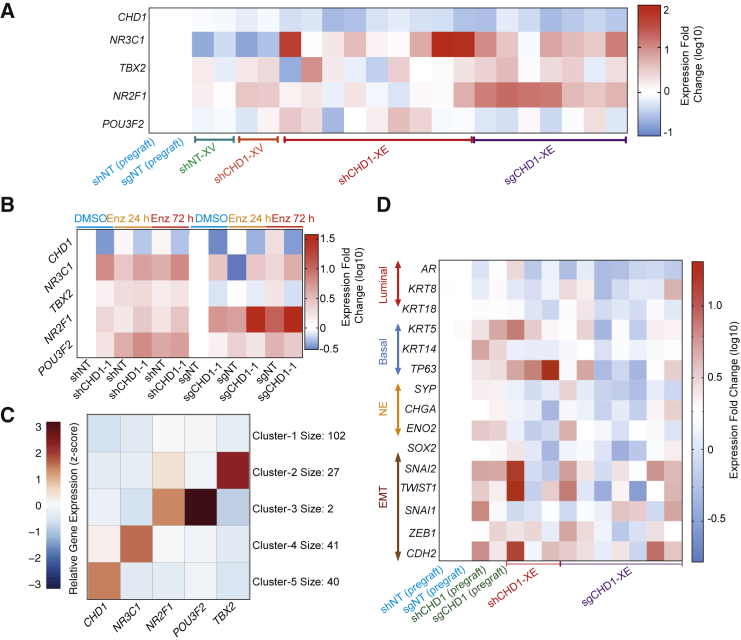
CHD1 Loss Enhanced Prostate Cancer Cell Heterogeneity and Lineage Plasticity(A) Heatmap represents the expression fold changes (qPCR) of the top four resistance driver genes and CHD1 in different xenografts derived cell lines, three technical replicates for each line.(B) Heatmap represents the expression fold changes of the top four resistant driver genes (qPCR) in shCHD1 cell line treated with 10 μM enzalutamide (Enz) in charcoal-stripped serum medium, three biological replicates for each line.(C) Unsupervised clustering of 212 patients based on the gene expression level (Z score) of CHD1 and the 4 TFs.(D) Relative gene expression level (qPCR) of lineage-specific markers and EMT genes in selective shCHD1-XE and sgCHD1-XE cell lines, three technical replicates for each line.See also Figure S7.